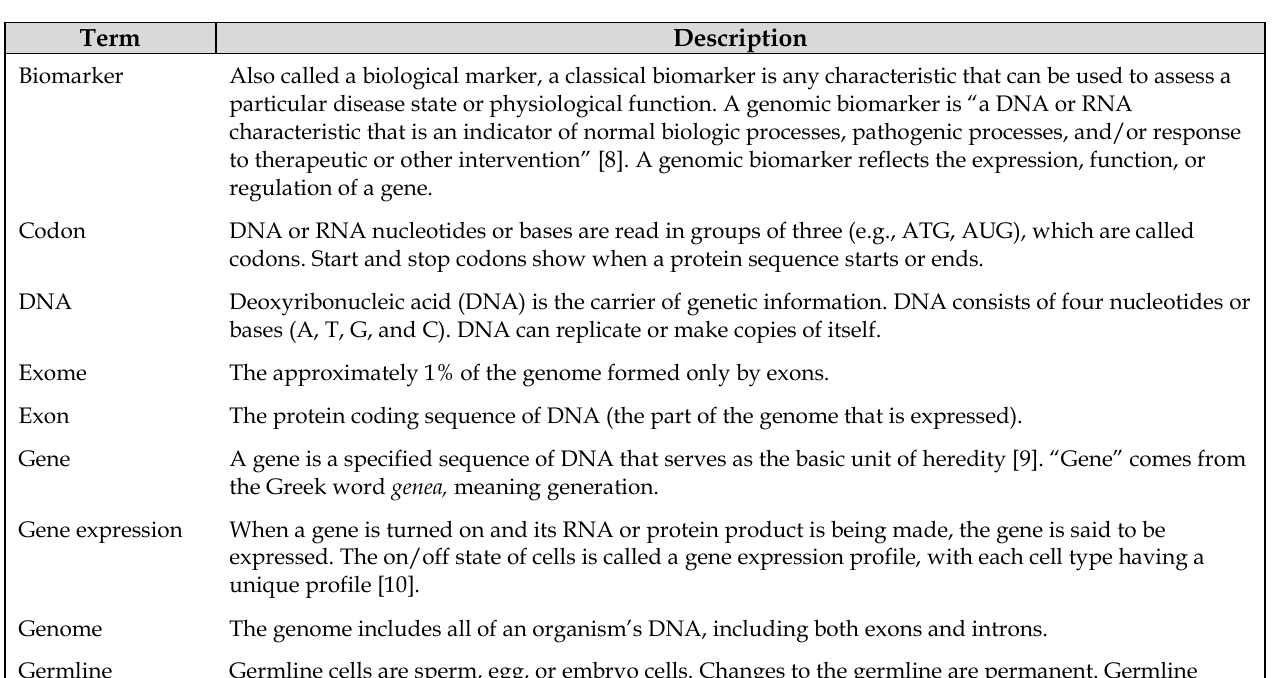
Table 1 Basic concepts in genomic